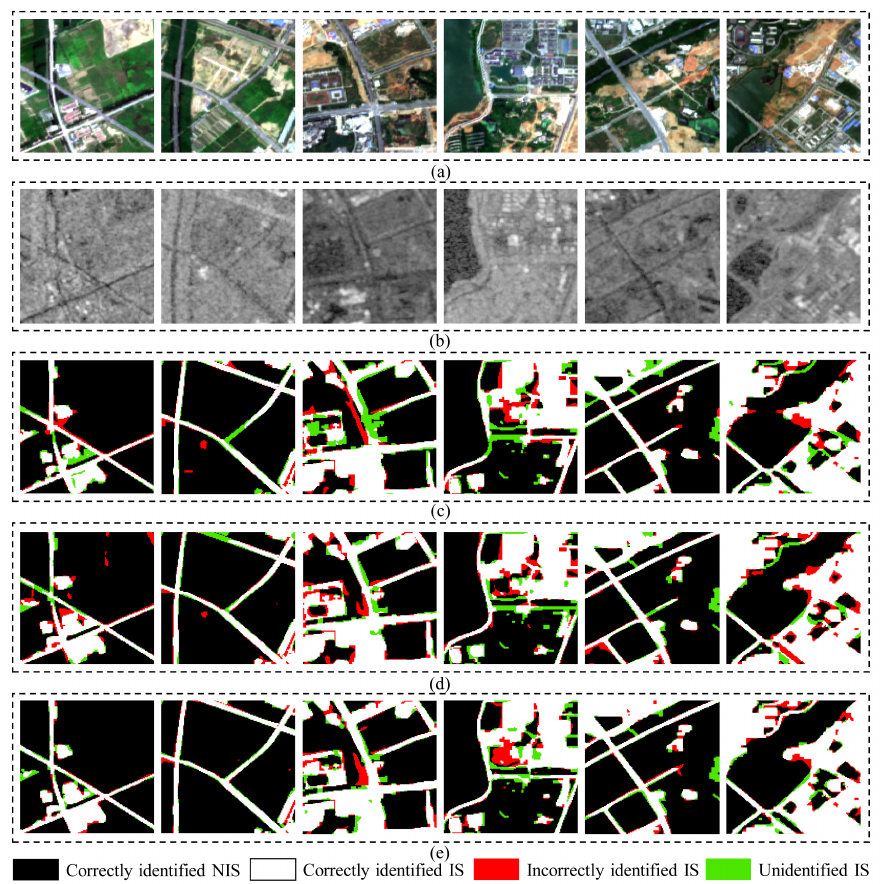
Figure 7. Qualitative impervious surface extraction results of different polarization channels. ( a ) Sentinel-2 image. ( b ) VH intensity image of Sentinel-1. ( c – e ) Impervious surface extraction results of VH polarization, VV polarization, and VH and VV polarization,